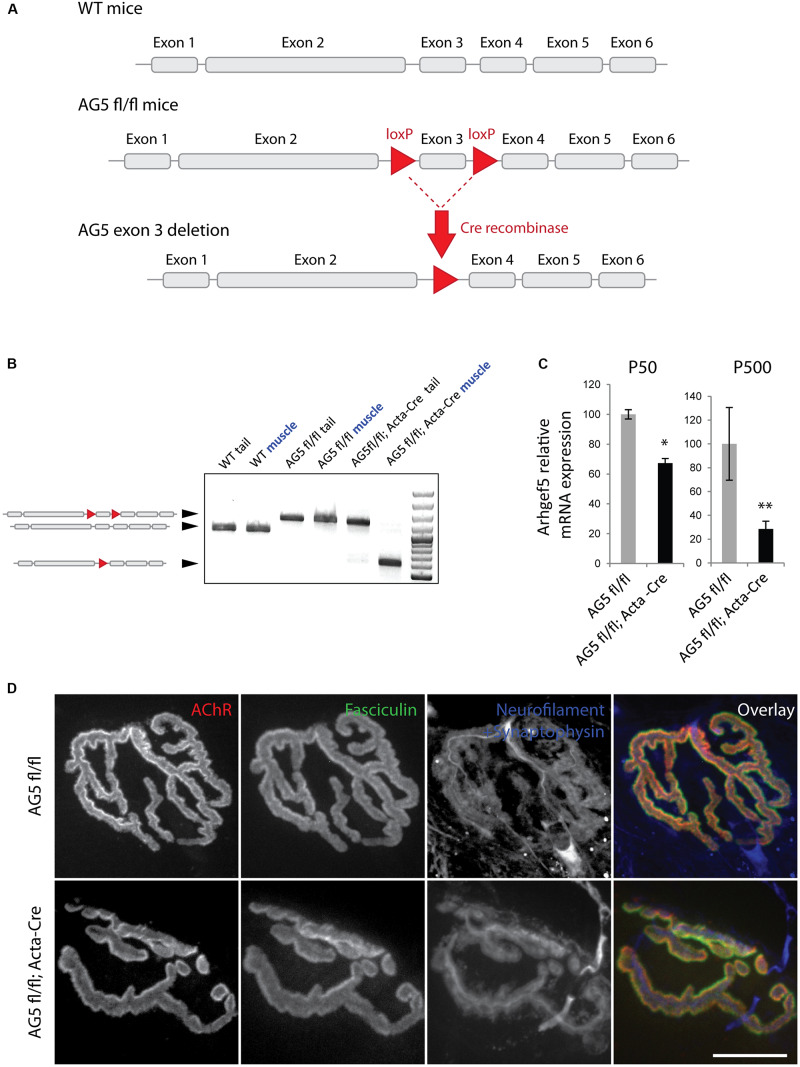
Generation of muscle-specific Arhgef5 KO mice. (A) Strategy for the generation of conditional Arhgef5 knockouts. Mice with loxP sites flanking the third exon of Arhgef5 were crossed with Cre-recombinase expressing mice to produce knockout. (B) Genotyping shows successful recombination in the muscles but not tail tipss of AG5fl/fl; Acta-Cre mice. (C) Quantification of Arhgef5 mRNA expression in AG5fl/fl and AG5fl/fl; Acta-Cre mice at 50 and 500 days of age. Results are mean ± SEM of three mice from each genotype. (D) Proper alignment of pre- and post-synaptic elements in AG5fl/fl; Acta-Cre muscles. Single fibers of tibialis anterior muscles isolated from AG5fl/fl and AG5fl/fl; Acta-Cre mice were stained with BTX (to visualize AChR), fasciculin II (to visualize the synaptic cleft marker acetylcholinesterase), and anti-neurofilament + anti-synaptophysin antibodies (to visualize the presynaptic nerve terminal). Scale bar is 20 μm. ∗p < 0.05, ∗∗p < 0.01.